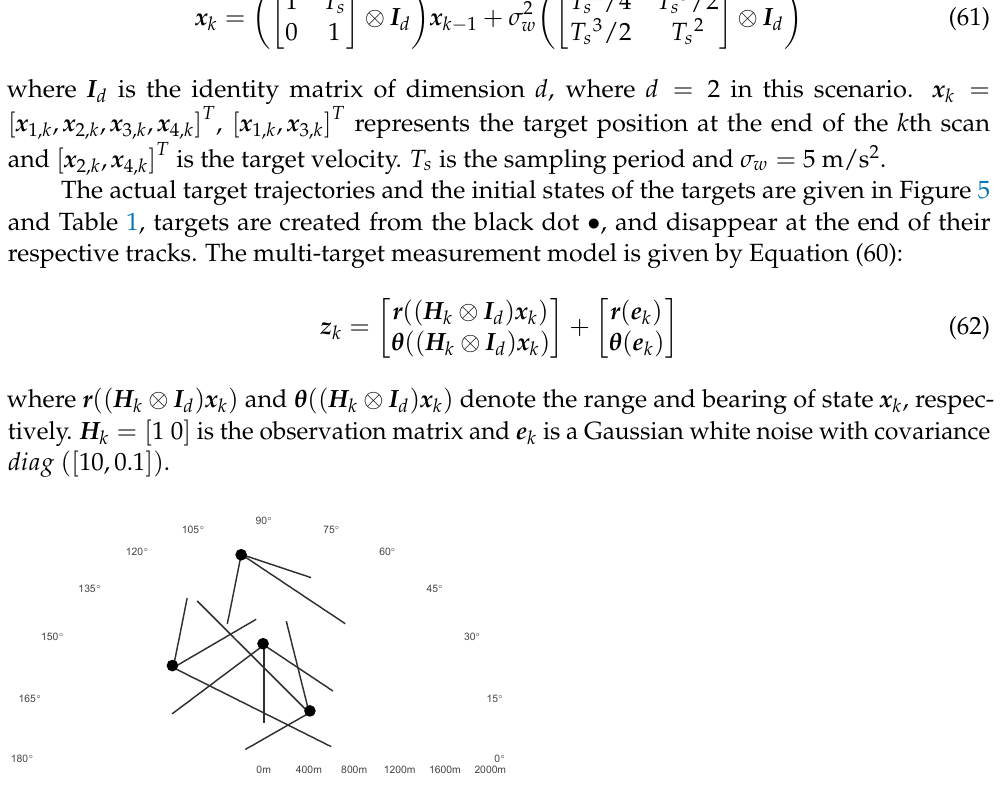
Figure 5. Target trajectories in example 1 (CV motion model), targets are created from the black dot • . Table 1. List of initial target states in example 1 (CV model).